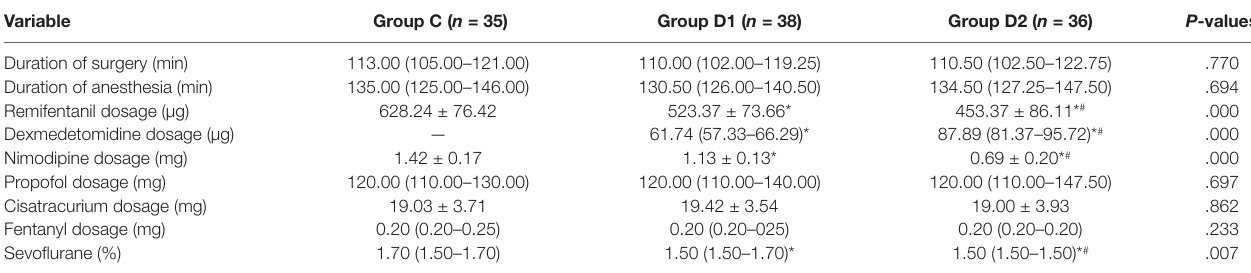
TABLE 2 | Comparison of intraoperative variables in the three groups. Variable